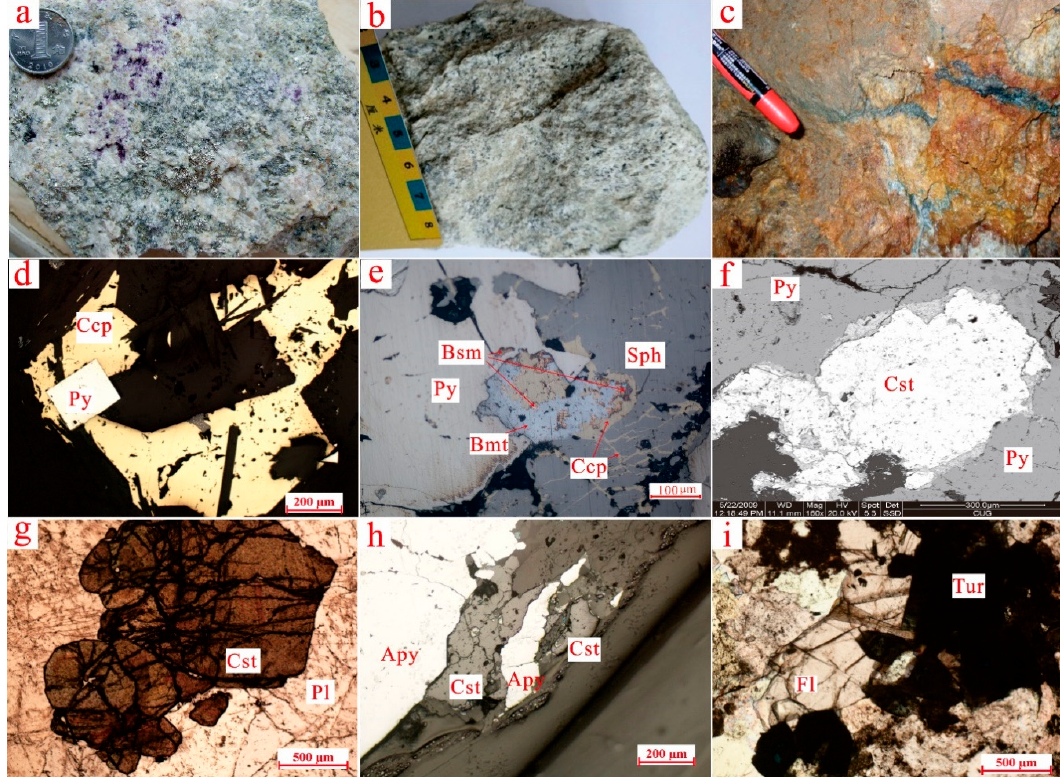
Figure 3. Photographs of tin ores from the Xi’ao Cu-Sn deposit; ( a ) is altered rock-type ore (XA-3) and mainly contains chalcopyrite, pyrite, sphalerite, quartz, fluorite, and cassiterite; ( d ) and ( e ) are photomicrographs of XA-3; ( f ) is the BSE image of XA-3; ( b ) is altered rock-type ore (XA-5) and mainly contains cassiterite, feldspar, and quartz; ( g ) is the photomicrographs of XA-5; ( c ) is tourmaline vein-type ore (XA-4) and mainly contains tourmaline, cassiterite, arsenopyrite, and fluorite; ( h ) and ( i ) is the photomicrographs of XA-4. Abbreviations: Ccp, chalcopyrite; Py, pyrite; Sph, sphalerite; Bsm, Bismuth; Bmt, bismuthinite; Cst, cassiterite; Pl, feldspar; Apy, arsenopyrite; Fl, fluorite; Tur, tourmaline.